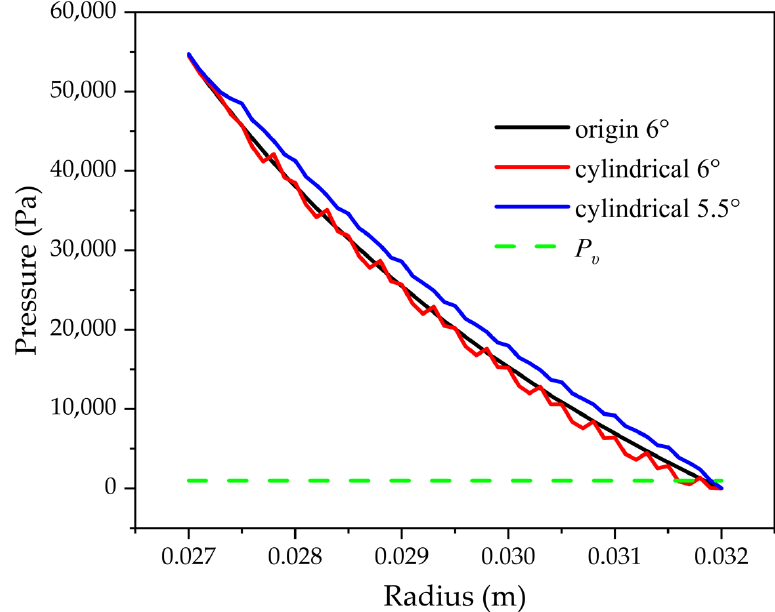
Figure 15. Radial pressure distribution along radial direction.